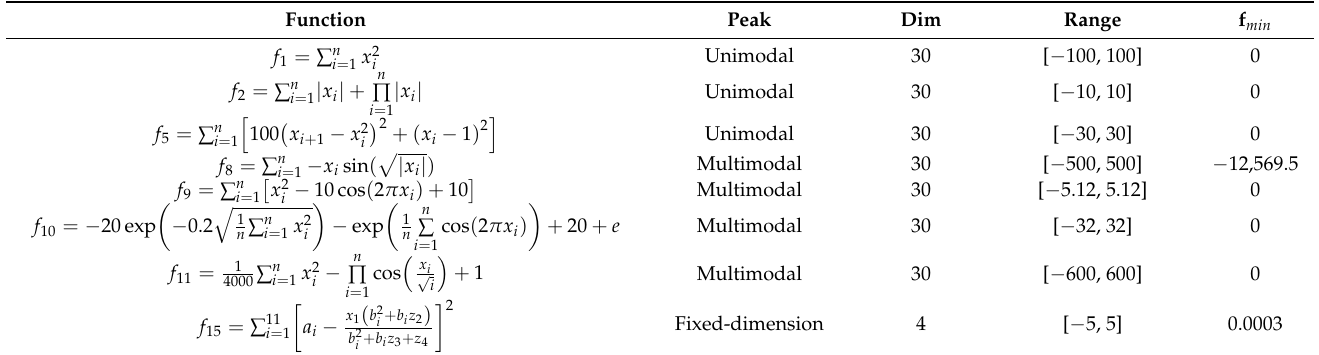
Table 5. Description of unimodal, multimodal and fixed-dimension benchmark functions. Function